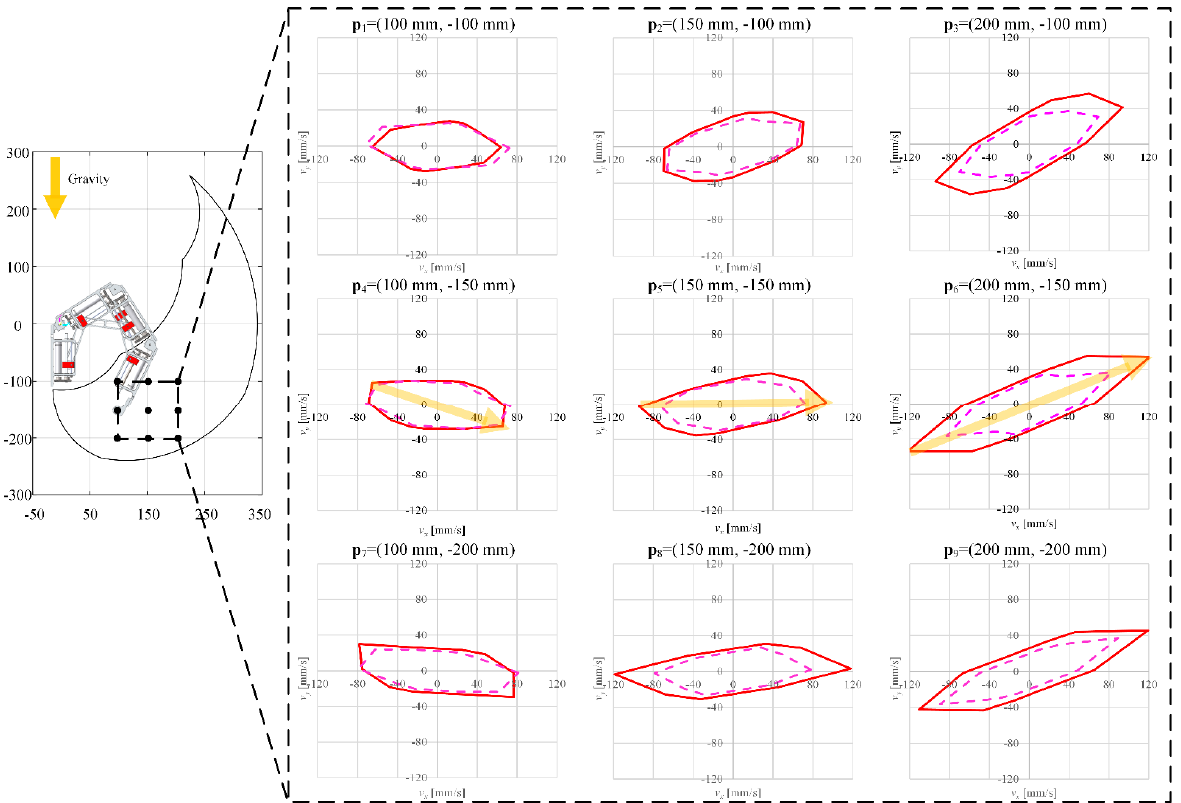
Figure 6. MPE results for the DAM-3R and JAM-3R at nine end-effector positions in the